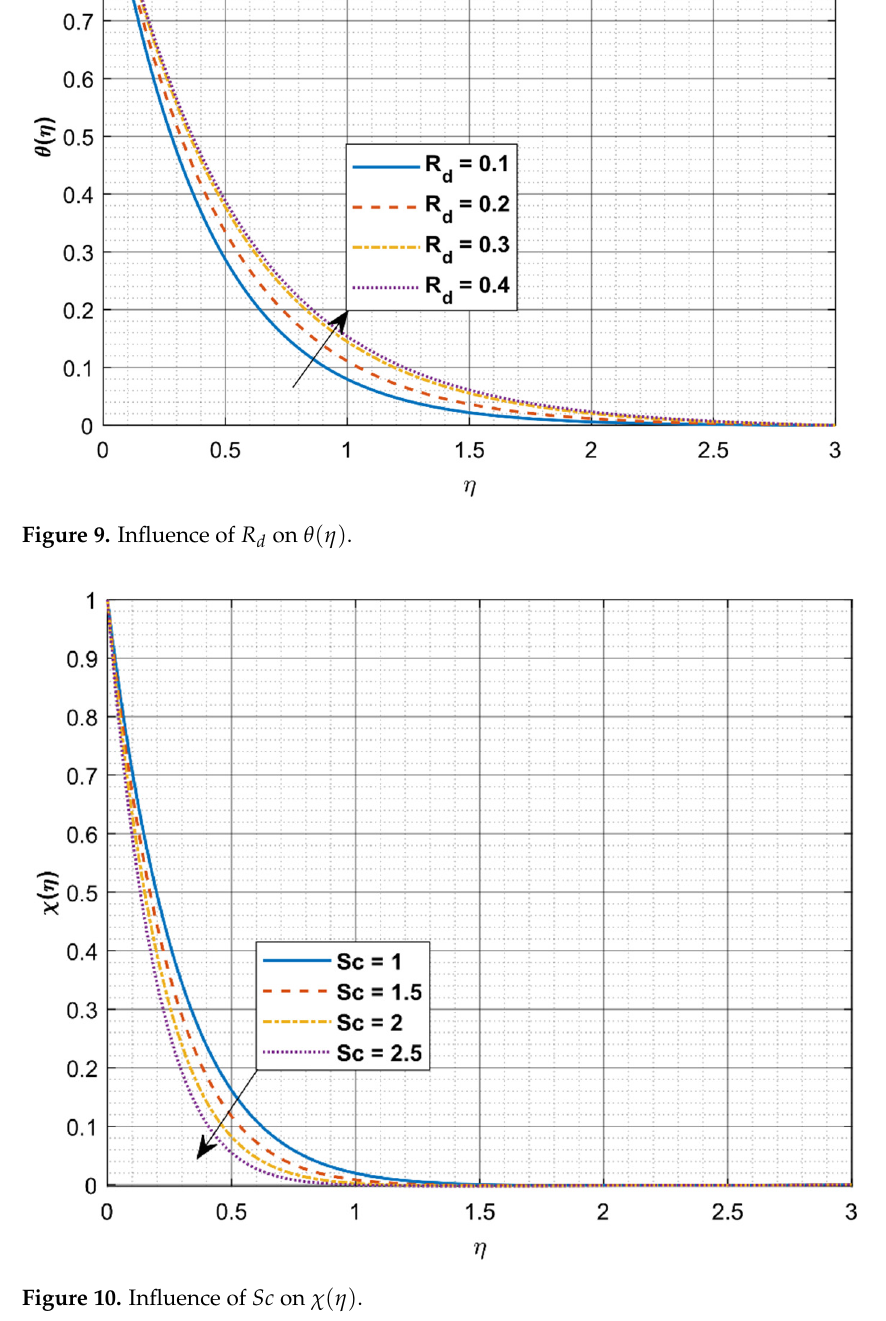
Figure 10. Influence of Sc on ( )